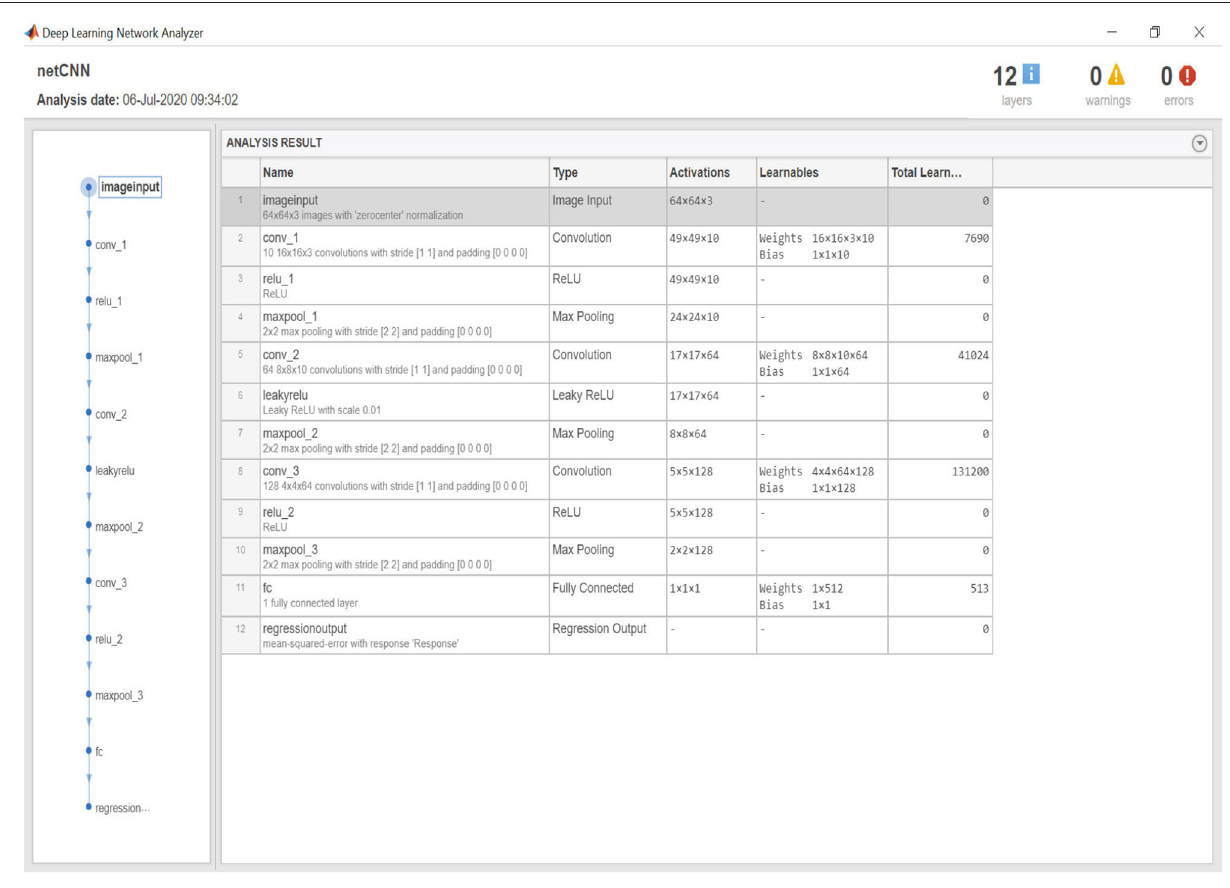
FIGURE 10 | Twelve layer architecture of CNN 2 with the number of activations per layer and total number of learnable weights and bias in the convolutional layers and fully connected